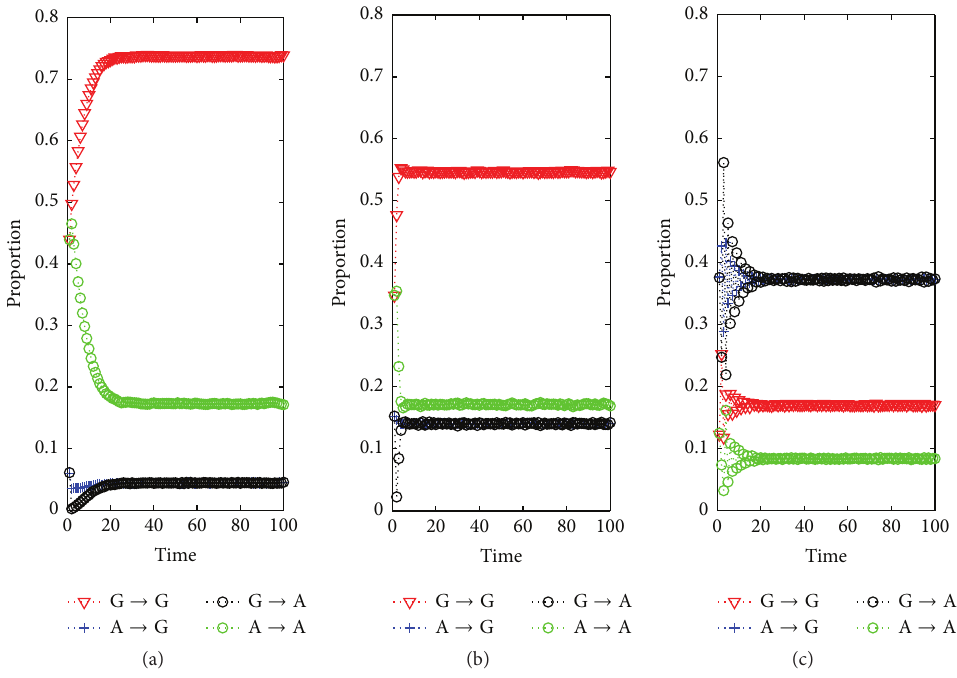
Figure 8: The proportion of strategy changing: (a) 𝐸 = 20 , (b) 𝐸 = 30 , and (c) 𝐸 = 50 .